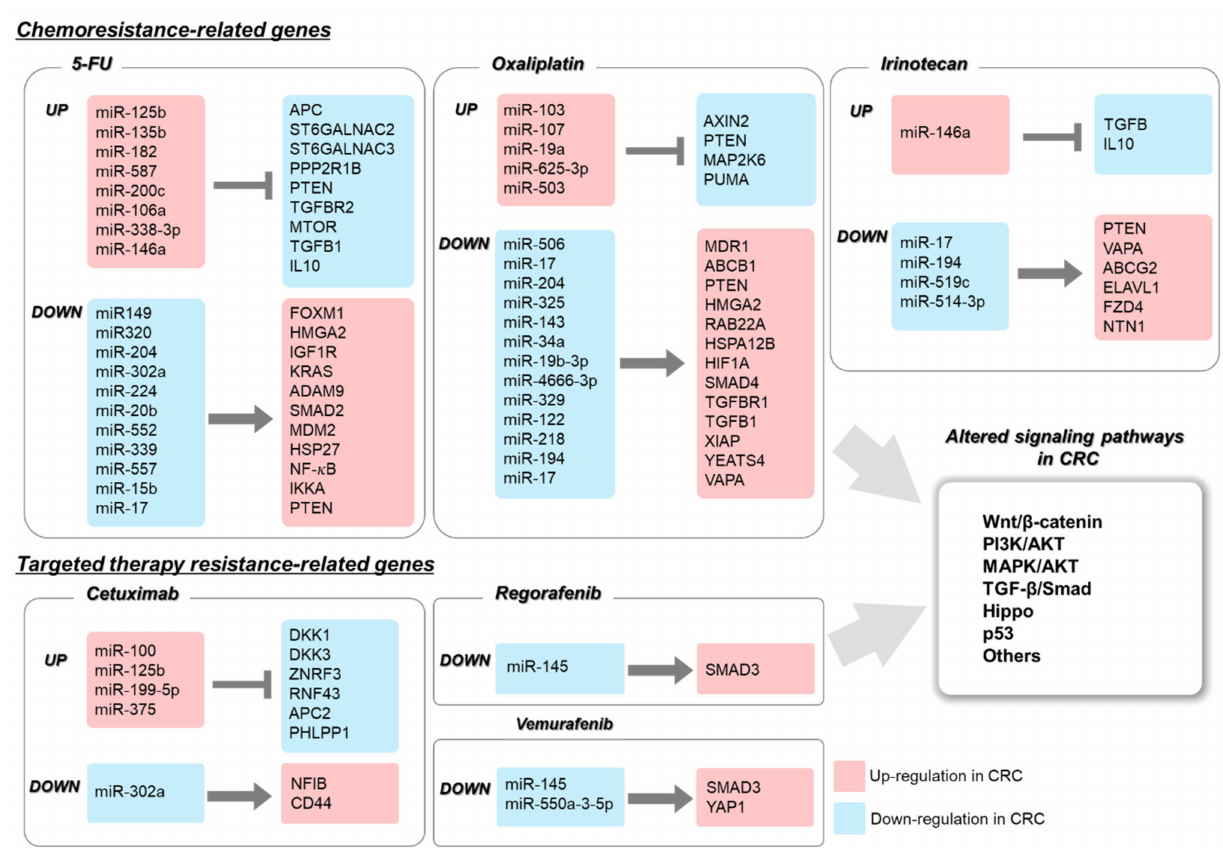
Figure 2. Summary for drug resistance-related miRNAs in